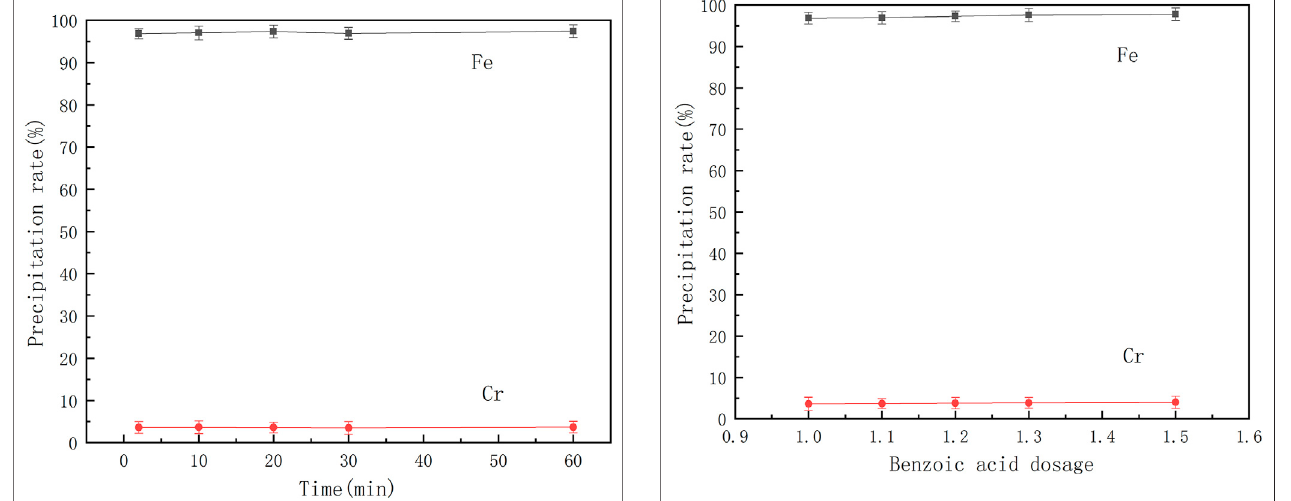
FIGURE 6 | Effect of reaction time on separation of ferrochromium.